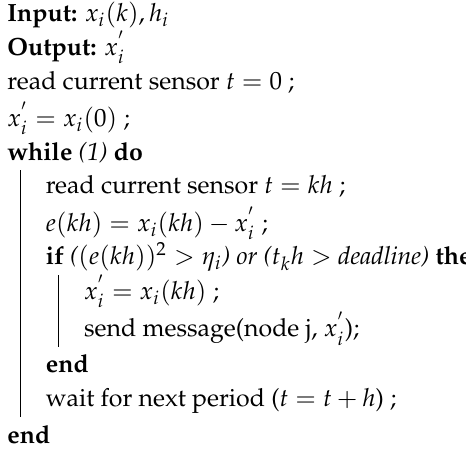
Algorithm 1: Smart sensor node